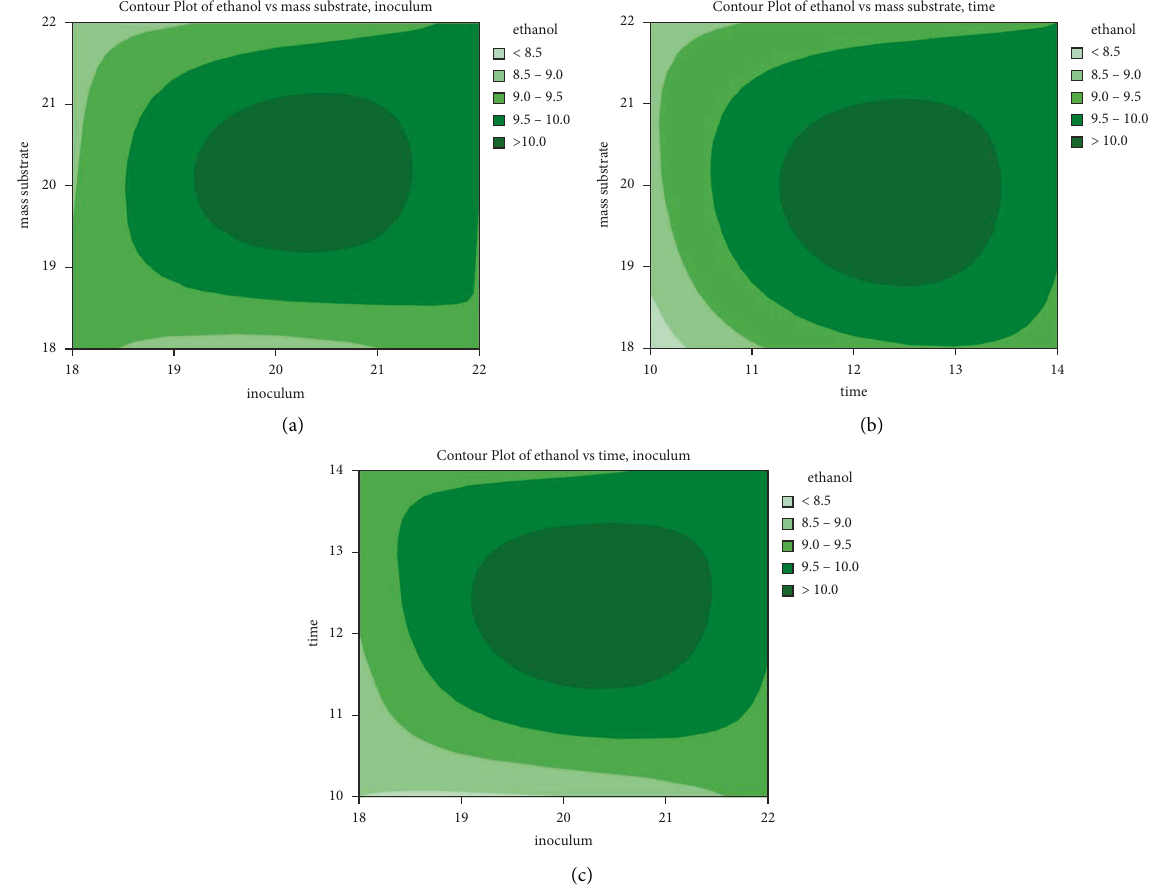
Figure 4: The contour plots of ethanol with two variables. (a) Mass substrate and inoculum, (b) mass substrate and time, and (c) inoculum and time.